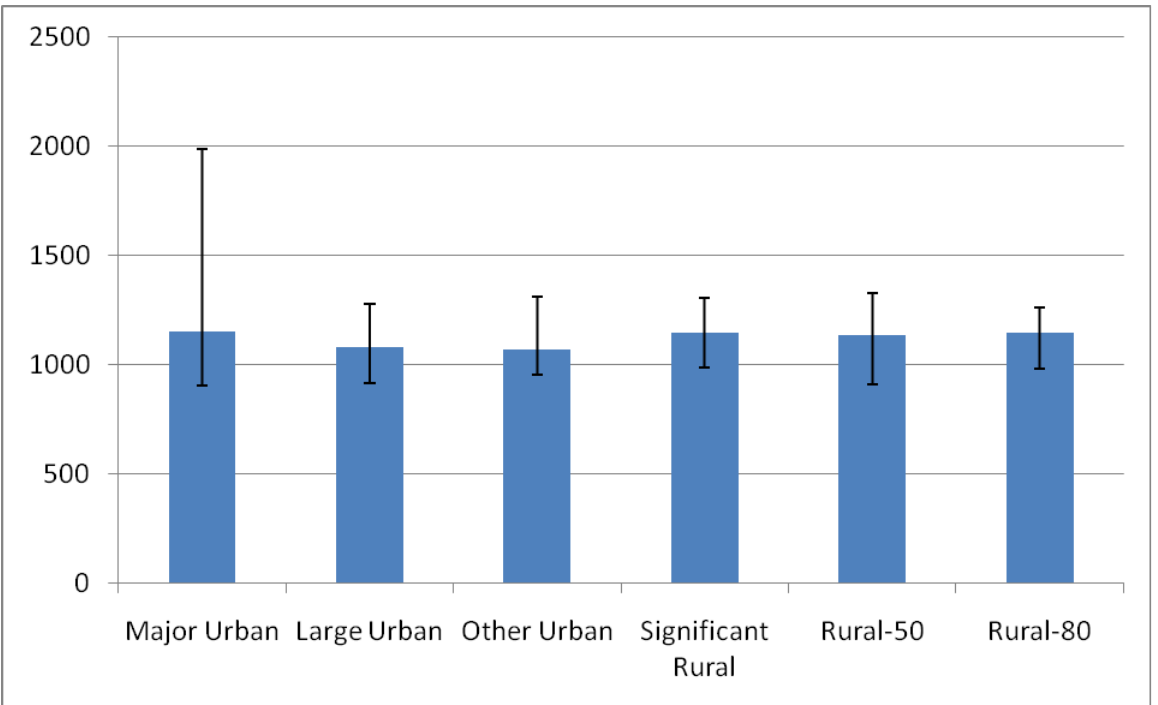
Figure 4. Consumption water footprint by degree of urbanization (m 3